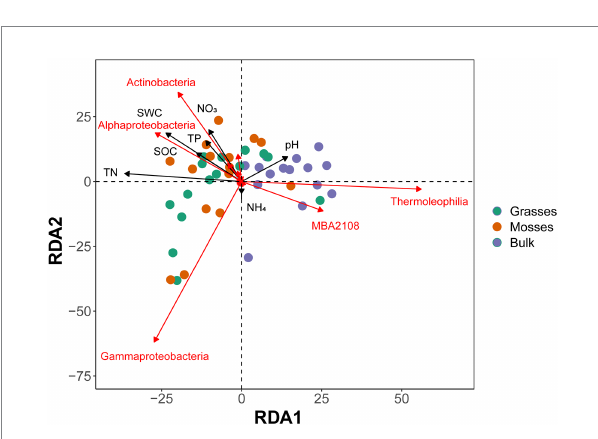
FIGURE 3 RDA (redundancy analysis) plot showing the effects of dominant plants and edaphic properties on the bacterial community at the class level from grasses, mosses and bulk soils. Abbreviations: SWC, soil water content; SOC, soil organic carbon; TN, total nitrogen; TP, total phosphorus; NO 3 − , nitrates; NH 4+ , ammonium. Only the bacterial classes with a large contribution to the first two axes are